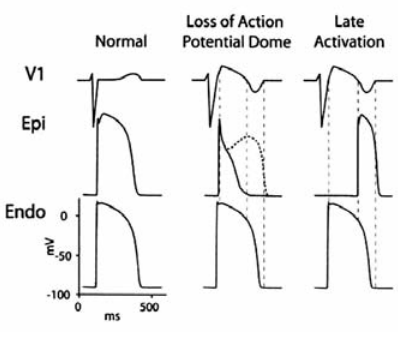
Figure 4. Proposed mechanisms of the Brugada type 1 ECG pattern. Loss of the action potential dome at the right ventric- ular subepicardium but not the subendo- cardium causes ST segment elevation and relative action potential prolongation at adjacent sites causes the negative T wave (repolarization hypothesis). Late activation of the right ventricle epicardium causes ST segment elevation and delayed repolariza- tion of the same myocardium causes the negative T wave (depolarization hypothe- sis). Modified from Hoogendijk et al. 23 with permission .